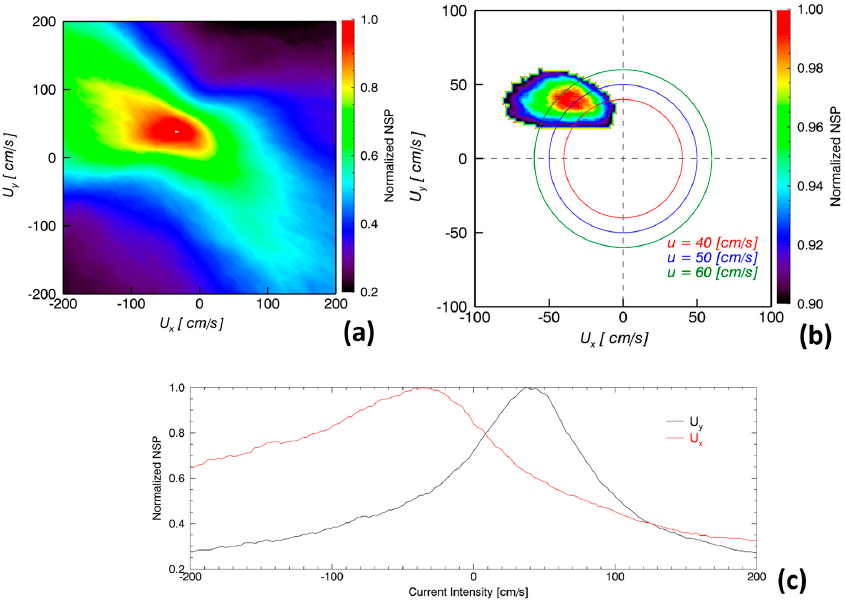
Figure 7. ( a ) Normalized scalar product (NSP) functional obtained by varying U x and U y components in the interval [ − 200 cm/s, 200 cm/s]; ( b ) NSP functional with values greater than 90% in the interval [ − 100 cm/s, 100 cm/s] and with overlapped three circles with radius equal to 40 cm/s, 50 cm/s and 60 cm/s; ( c ) The behavior of the NSP Functional along the two current components passing through the estimated value U x = − 36 cm/s, U y = 38